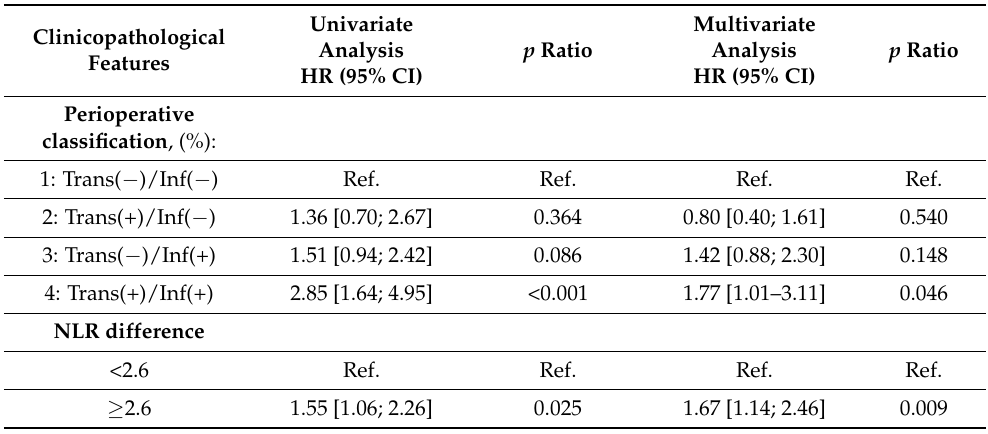
Figure 3. Kaplan–Meier analysis of probability of disease-free survival according to the NLR change cut-off. Table 3. Univariate and multivariate analyses of clinicopathological variables in relation to disease- free